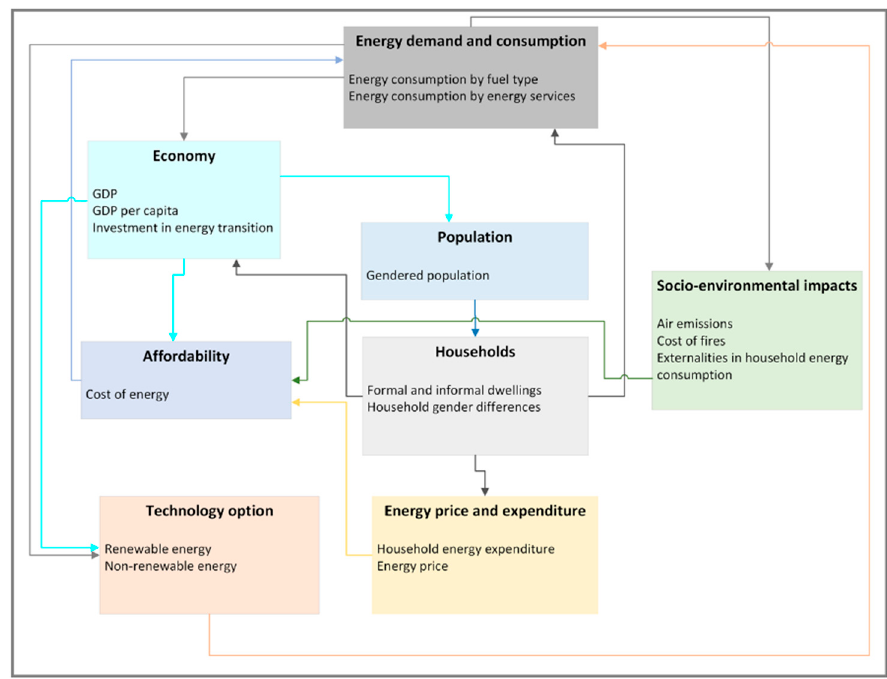
Figure 1. Generic sub-systems structure for analysing gendered urban households’ energy transition. Source: Authors.